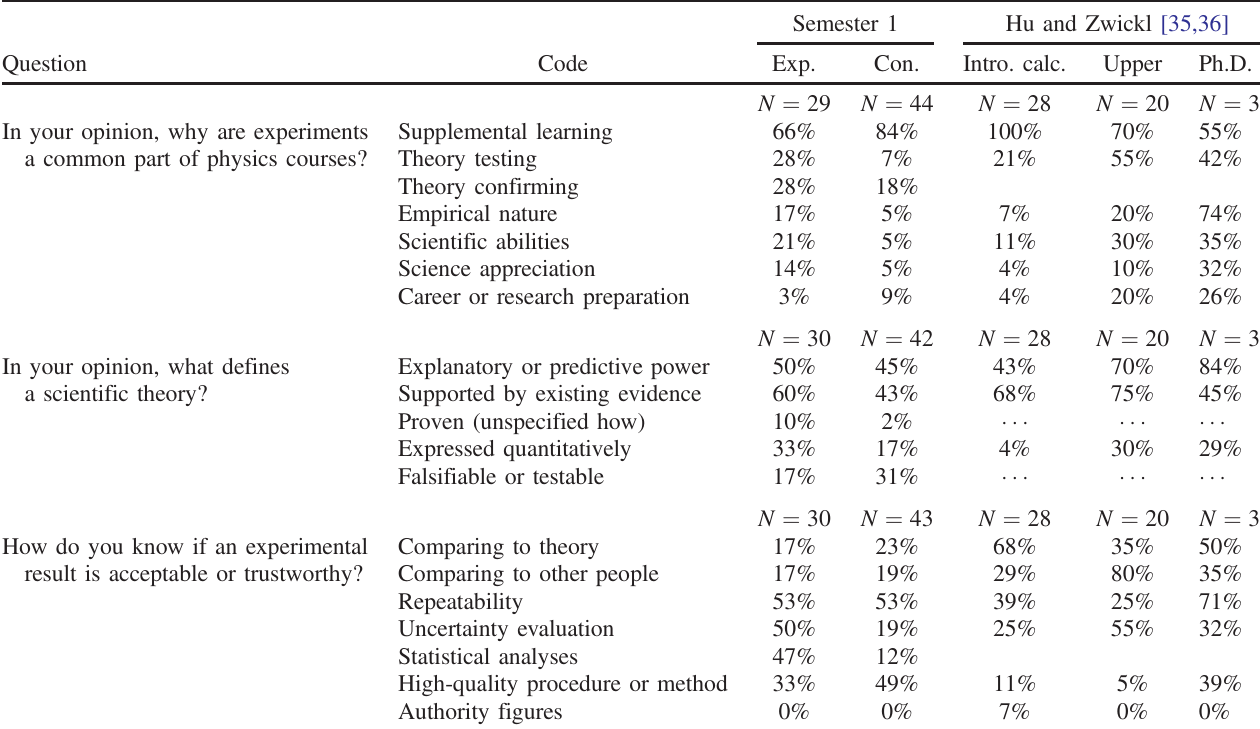
TABLE VI. An analysis of LES responses finds that students ’ explanations for why experiments are part of physics courses and their criteria for trustworthy experimental results differ across lab conditions. Multiple codes may apply to a response, so totals exceed 100%. Vague responses are removed from the analysis, accounting for differing numbers of responses by question. Hu and Zwickl ’ s results are next to the corresponding code(s); we split two of their original codes into two separate